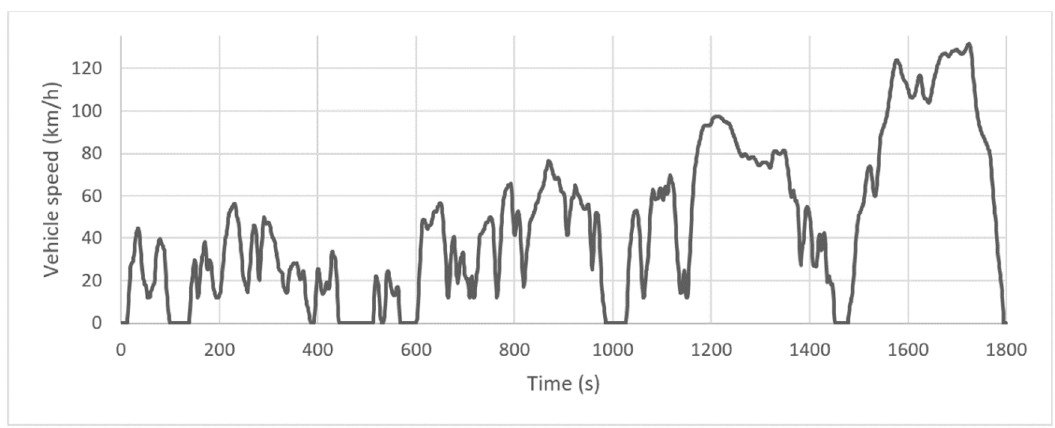
Figure 6. Vehicle speed through the Worldwide Harmonised Light Vehicle Test Procedure (WLTP) driving cycle.